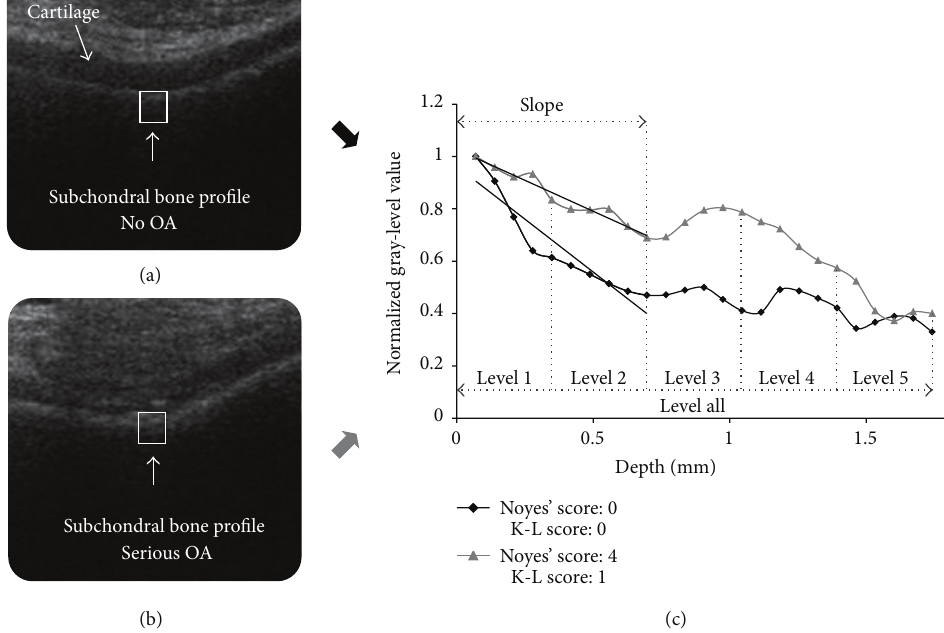
Figure 1: (a) Ultrasound image of healthy knee cartilage-bone interface. A rectangular bone segment was selected in location perpendicular to the incident ultrasound beam. (b) Ultrasound image of osteoarthritic knee cartilage-bone interface. (c) Comparison of nonosteoarthritic (black) and osteoarthritic (gray) subchondral bone gray-level intensity profiles demonstrating decreasing subchondral bone reflection with depth. Five uniform depth levels, overall bone level and slopes calculated for first 2 levels are